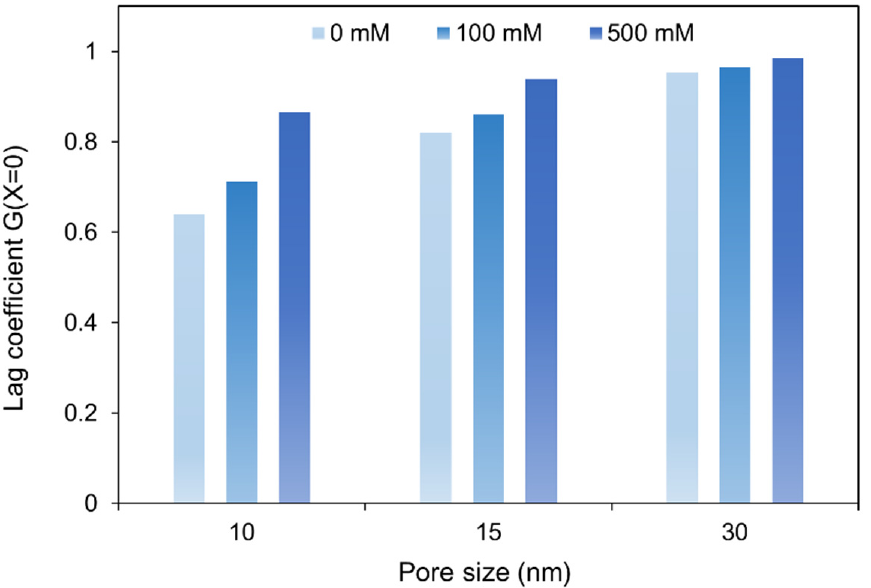
developed by Higdon and Muldowney [50] (Equation (13)). In Figure 3, the lag coefficient of poly(dT 60 ) ssDNA in different membrane pore sizes for three different NaCl concentrations are compared. The radius of gyration of poly(dT 60 ) ssDNA was used as the solute size in these calculations.